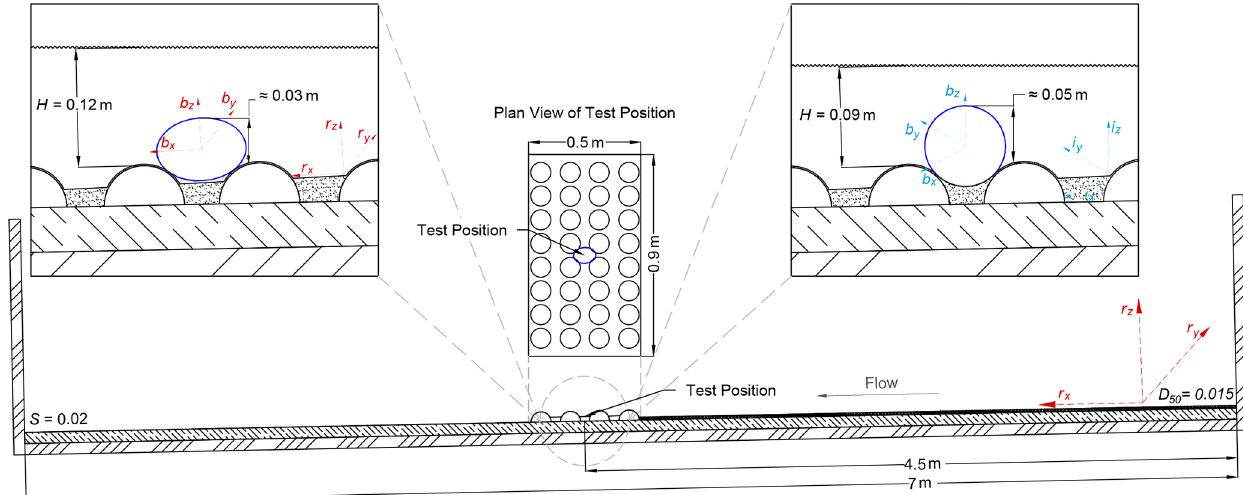
Figure 2. Laboratory setting and initial alignment. The diagram shows the arrangement of the bed of hemispheres and the test position (4.5m downstream of the entrance of the flume). Upstream of the bed of hemispheres, the flume was filled with densely packed gravel ( D 50 = 0 . 015m, black layer upstream of the hemisphere section in the graph) to enable the development of the flow. The sphere diameter is 0.09m, and ellipsoid b axis is 0.07m. The height of the centroid above the crest of the glued hemispheres is approximately 0.02m for the sphere and 0.015m for the ellipsoid. The depths correspond to the hydraulics at the point of entrainment, summarised in Table D1. r stands for riverbed (flume in this case) reference frame, b for body frame and i for the inertial reference frame ( r Appendix A). S is the slope of the channel (0.02). The sketch also depicts the initial alignment for each device ( b − i for the sphere and b − r for the ellipsoid). While the spherical particle was in full contact with the bed (hemispheres and coating/filling gravel), the setting could result to a film of water flowing underneath the